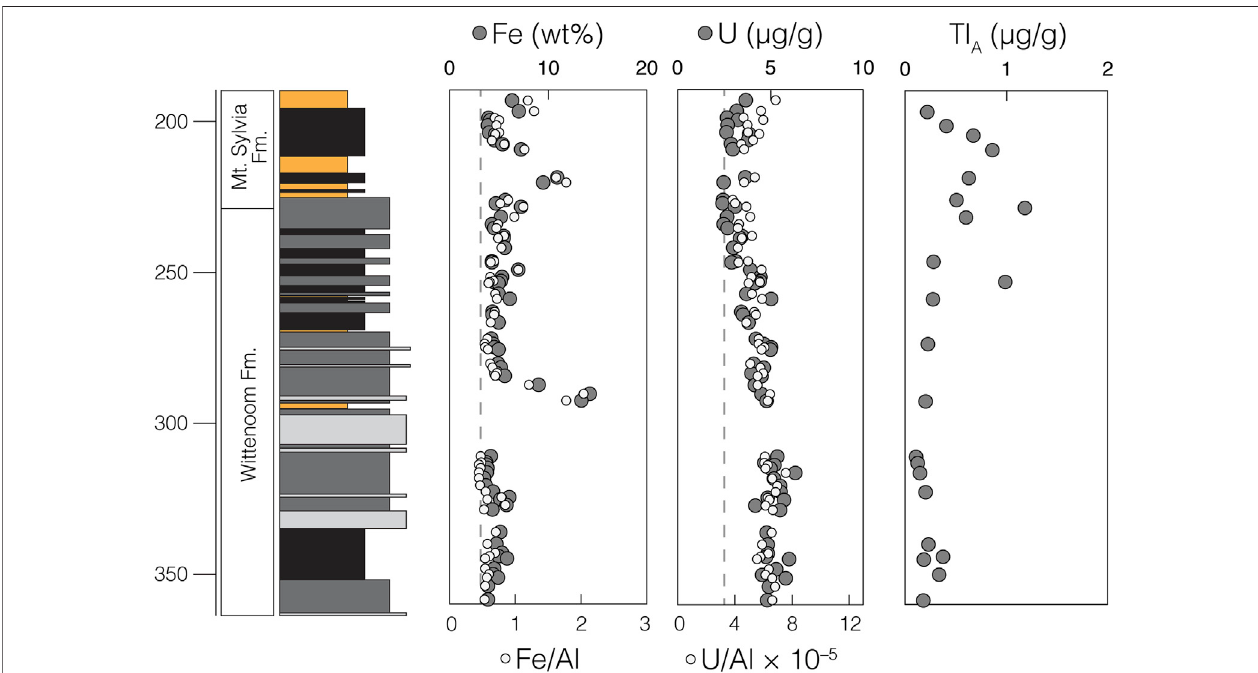
FIGURE 4 | Trace metal concentration data generated during the current study. Dark gray datapoints represent non-normalized concentrations for bulk-shale (Fe and U) and leached authigenic fractions (Tl A ). Light gray datapoints represent concentrations normalized to the non-redox sensitive element Al and gray dashed lines represent average upper continental crust values for these ratios (Rudnick and Gao